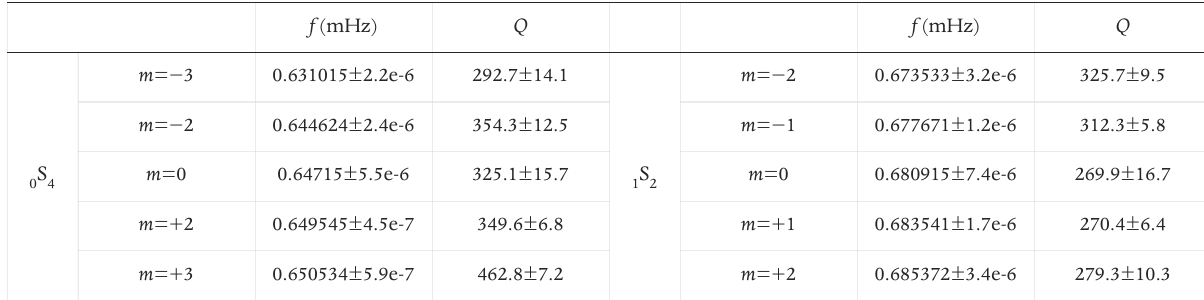
S and S in this 0 4 1 2